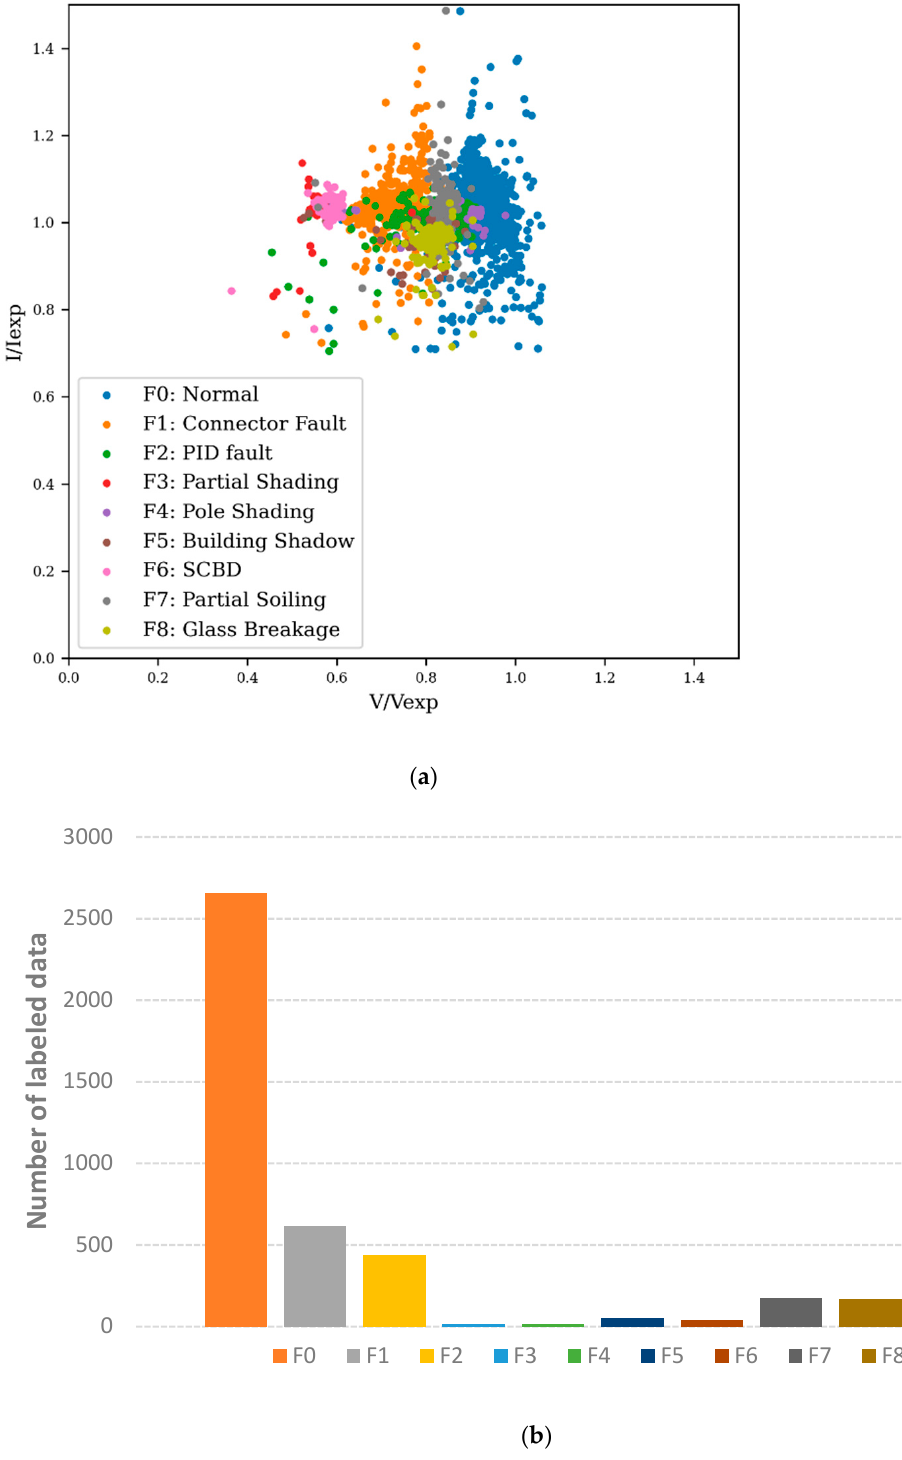
Figure 7. Experiment data distribution: ( a ) normalized current vs. voltage under various conditions; ( b ) distribution of labelled data.